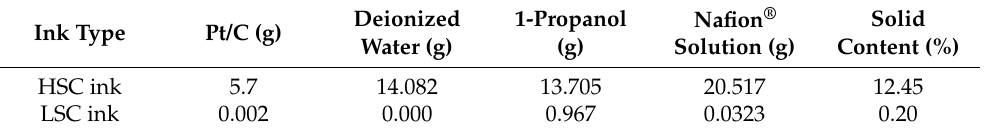
Table 1. Sample composition of catalyst